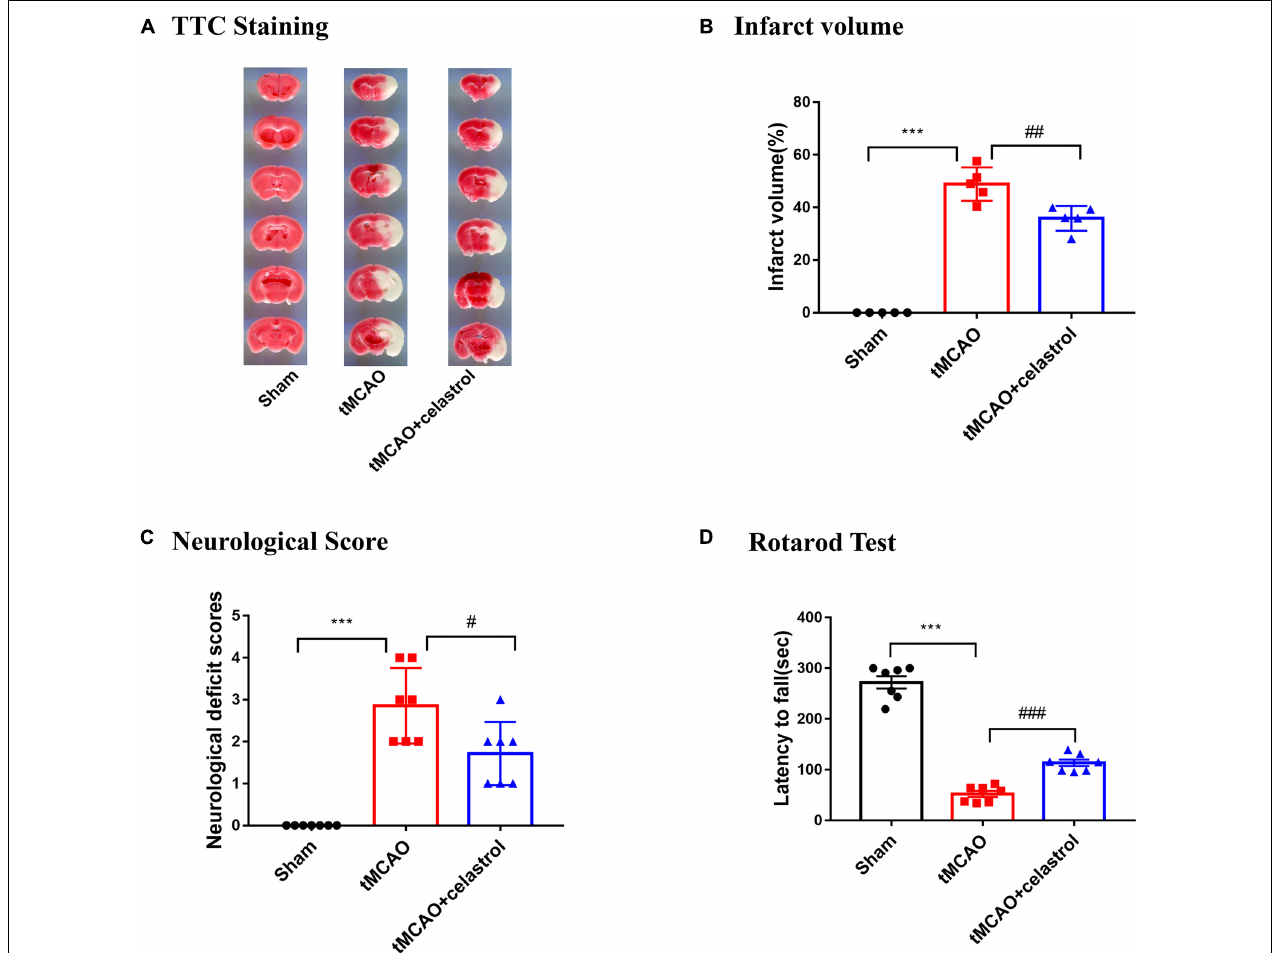
FIGURE 1 | (A,B) Celastrol reduced infarct volume in tMCAO mice. *** P < 0.001 vs. sham group; ## P < 0.01 vs. tMCAO group, n = 5. (C,D) Celastrol improved neurological deficit scores and motor function in tMCAO mice. *** P < 0.001 vs. sham group; # P < 0.05, ### P < 0.001 vs. tMCAO group, n =